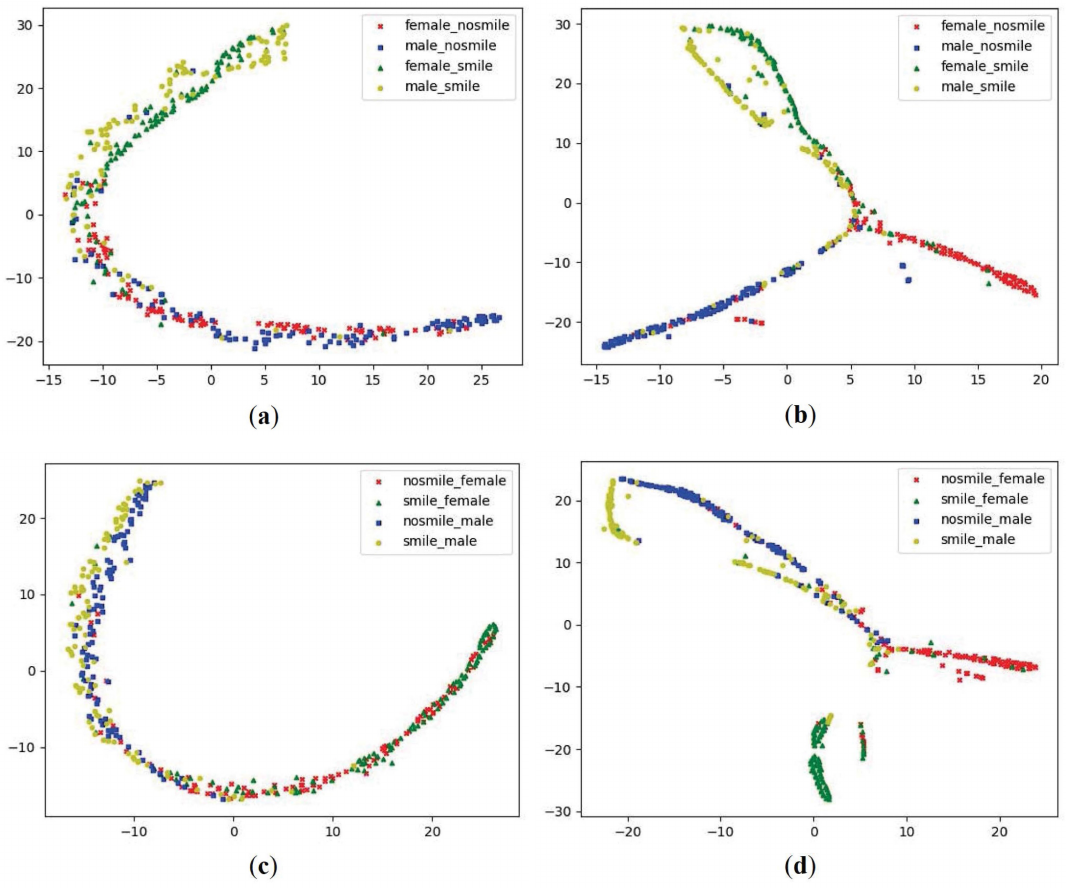
Figure 6. t-SNE visulization on the sampled LFWA validation dataset. ( a ) t-SNE visulization of FC S ; ( b ) t-SNE visualization of FC S | C ; ( c ) t-SNE visualization of FC G ; ( d ) t-SNE visualization of FC G | C G